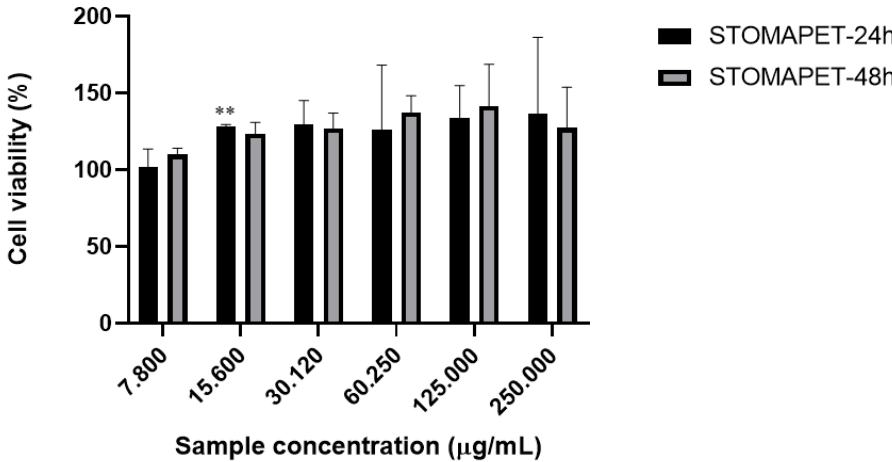
Figure 4. The effect of STOMAPET on SC cells exposed for 24 and 48 h (MTS assay). Values represent mean ± SD (n = 3, * p < 0.05, ** p < 0.01, *** p < 0.001). mean ± SD (n = 3, * p < 0.05, ** p < 0.01, *** p < 0.001).